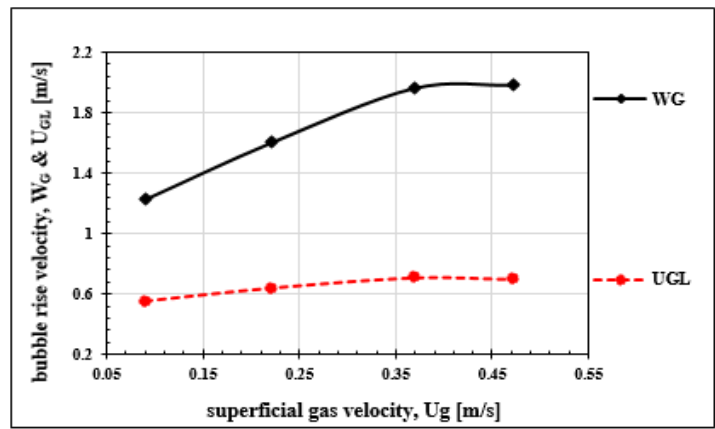
Figure 19. Relationship between bubble rise velocity ( U GL and W G ) and superficial gas velocity ( U G